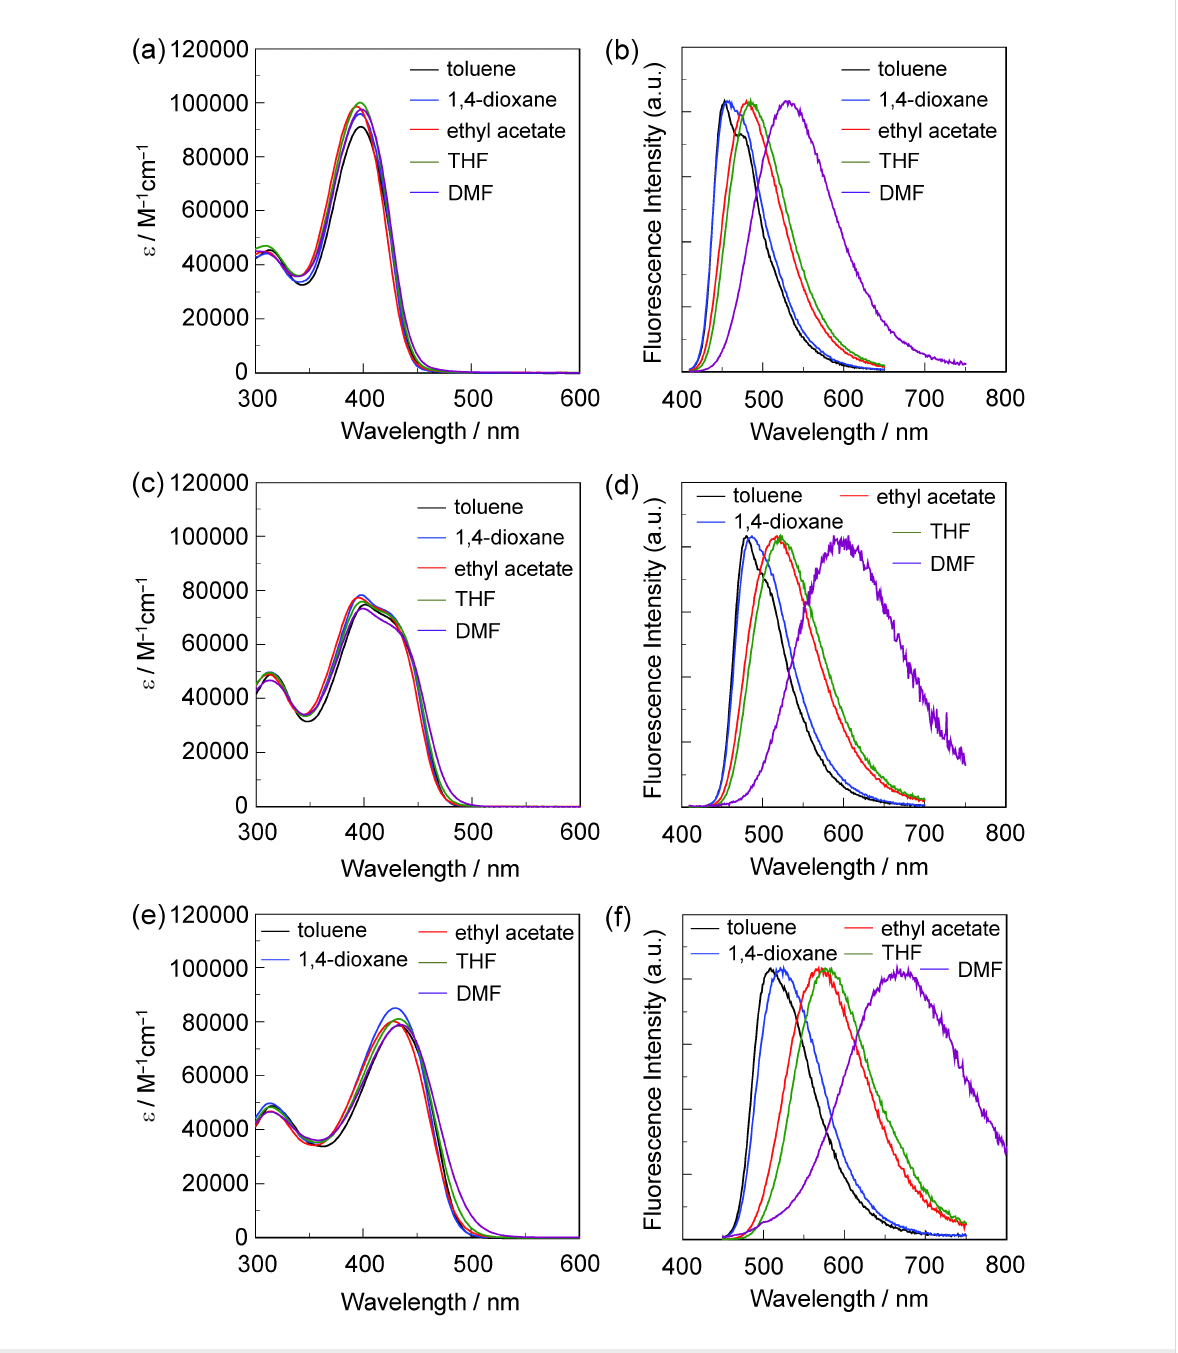
Figure 2: (a) Photoabsorption and (b) fluorescence ( λ ex = ca. 400 nm) spectra of OUY-2 in various solvents. (c) Photoabsorption and (d) fluores- cence ( λ ex = ca. 400 nm) spectra of OUK-2 in various solvents. (e) Photoabsorption and (f) fluorescence ( λ ex = ca. 430 nm) spectra of OUJ-2 in various